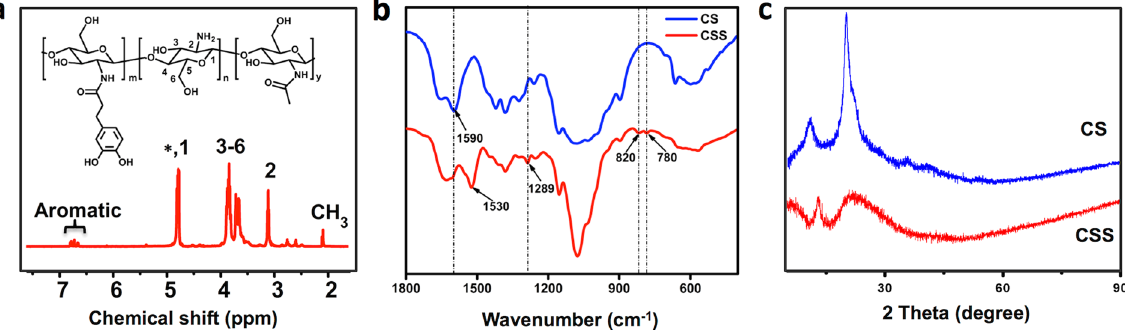
Figure 2. Characterization of CSS. ( a ) 1 H NMR spectrum of CSS, ( b ) FT-IR spectrum of CS and CSS, ( c ) XRD analysis of CS and CSS.